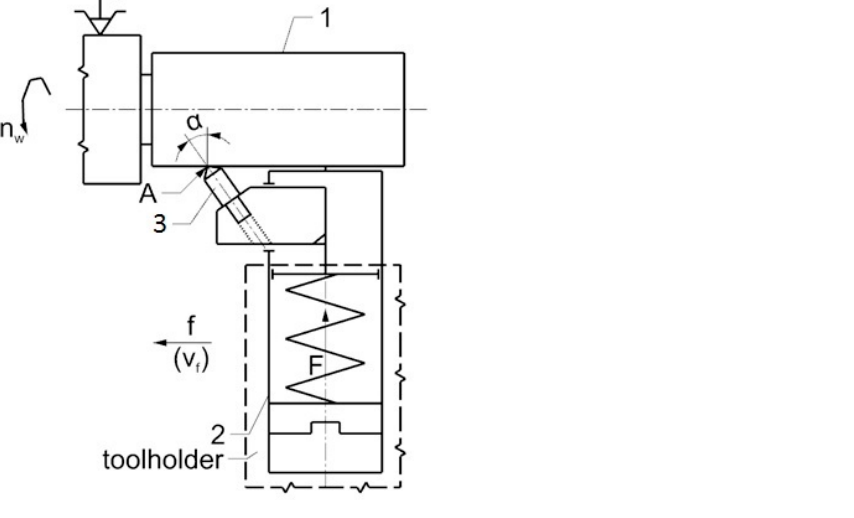
Figure 1. A schematic diagram of sliding friction burnishing (1—workpiece, 2—burnishing tool, 3—burnishing insert, A—active element of tip).